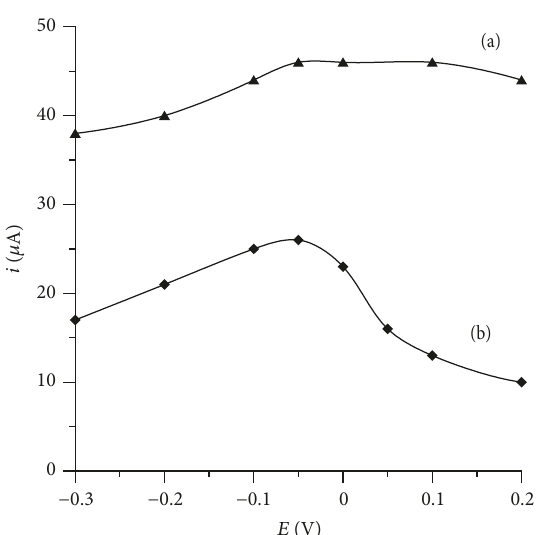
Figure 2: The influence of accumulation potential on the 2 × 10 −8 mol L −1 Bi(III) (a) and 2 × 10 −8 mol L −1 Pb(II) (b) peak current. Concentration of cupferron 1 × 10 −4 molL −1 and acetate buffer 0.1 molL −1 (pH = 4.5). Accumulation time 30 s.